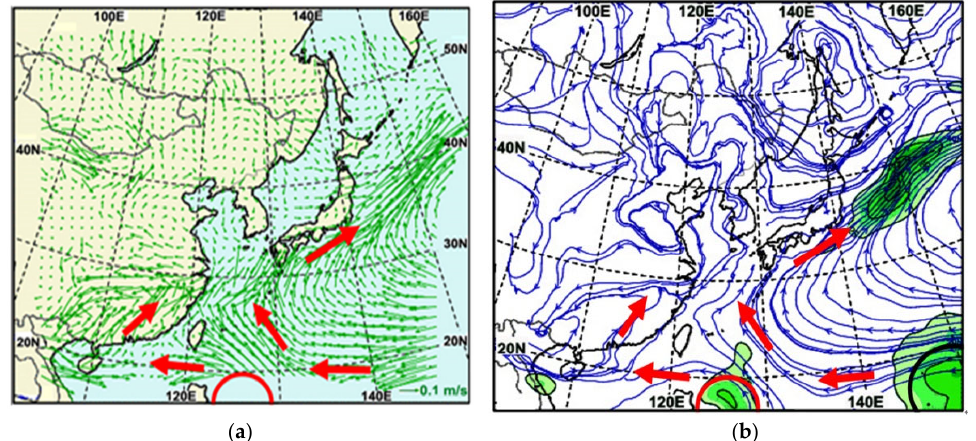
Figure 4. ( a ) Moisture flux (0.1 kg ∙ m/s) and ( b ) streamline with isotachs (green color areas greater than 25 kt) at 850 hPa (1.5 km height) at 09:00 LST, 4 July 2015. TS Linfa (bottom ‐ center) moving west ‐ northwestward and TY Chan ‐ Hom (bottom ‐ right) moving westward were steered north ‐ wards by the southwest wind ahead of the MLCT enabling their cyclonic circulations to intensify when no interaction between tropical cyclones existed. Moisture converged into the MLCT. Even though COMS ‐ IR images showed the two tropical cyclones close to one another, their circulations were independent. However, they both interacted with a cloud